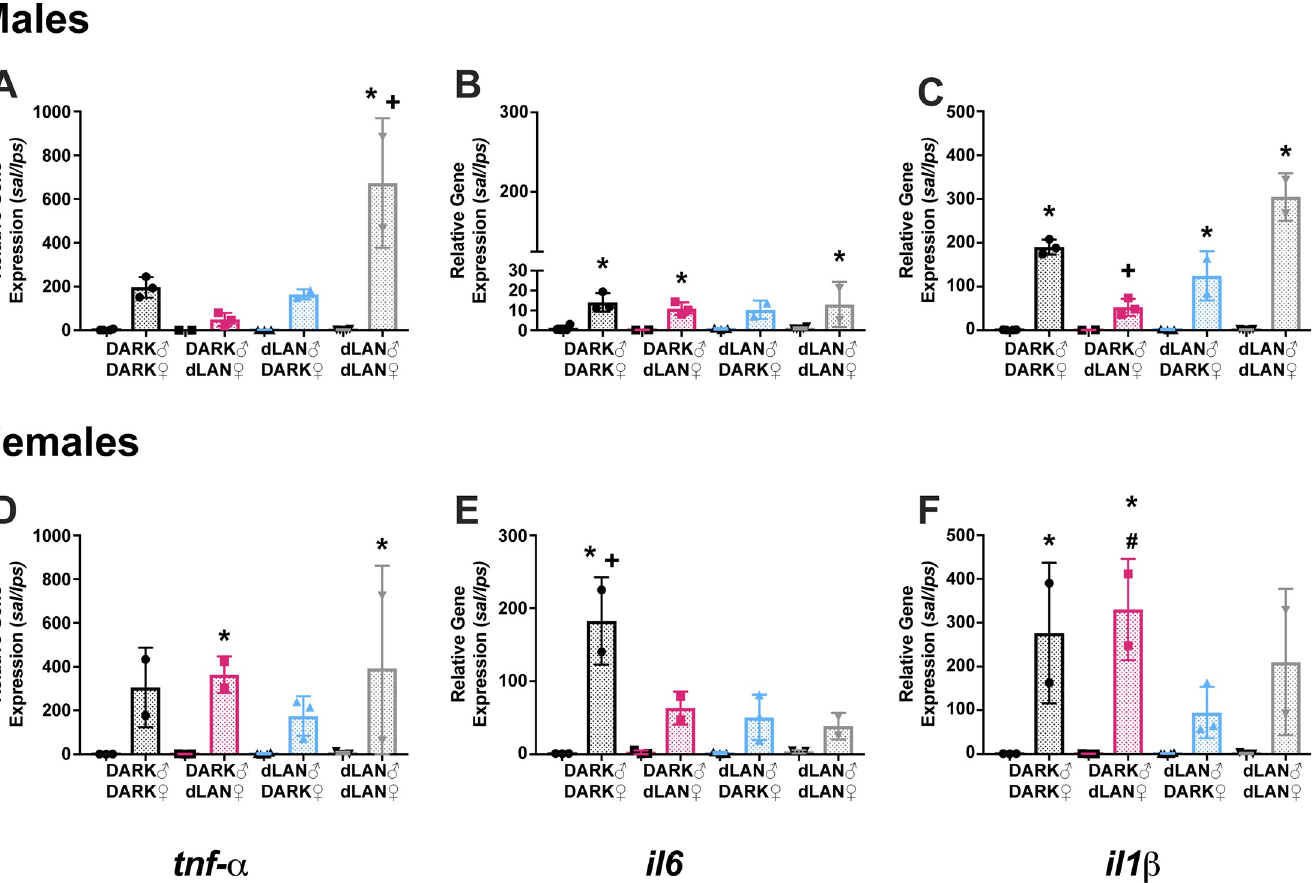
Fig 4. Paternal dLAN blunted hypothalamic cytokine gene expression in female offspring. Hypothalamic tnf- α , il-1 , and il-6 expression 3 hours post-LPS challenge in males (A-C) and females (D-F). Open bars represent saline, dotter bars represent LPS. N = 2-4/group/sex; error bars represent SD. +, P < 0.05 vs all LPS; #, P < 0.05 vs dLAN-Dark LPS; � , P < 0.05 saline vs